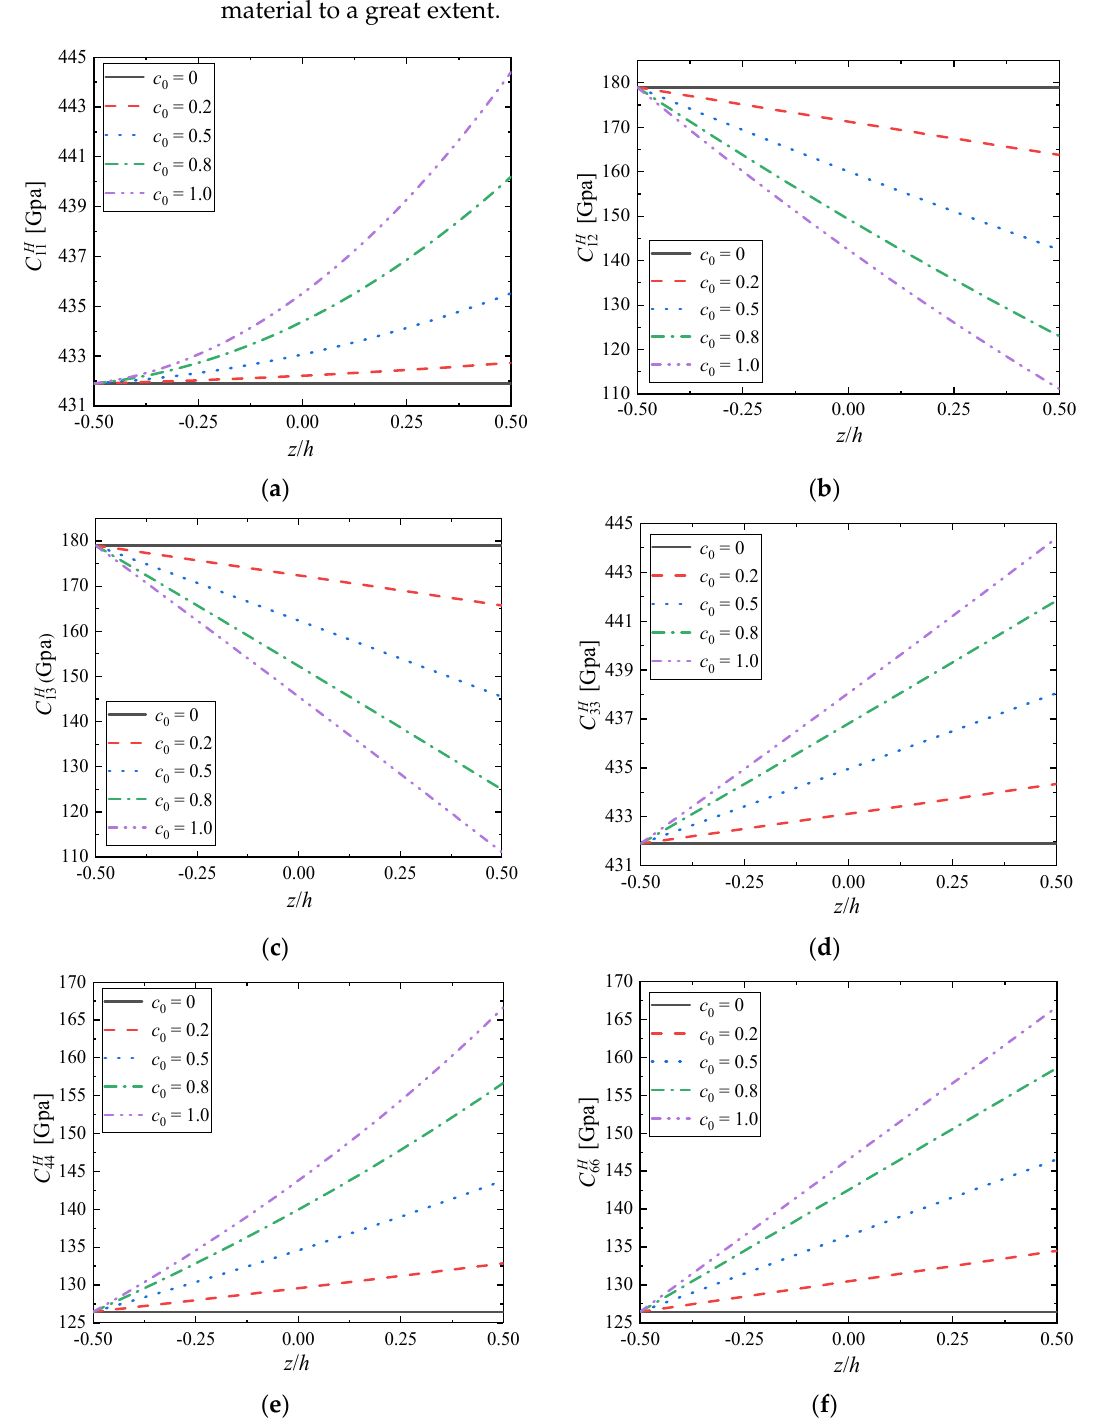
Figure 6. Distributions of ( a ) C 11 H ; ( b ) C 12 H ; ( c ) C 13 H ; ( d ) C 33 H ; ( e ) C 44 H ; ( f ) C 66 H along the gradient direction when m = 1.0. In Figure 7, when the component ratio coefficient c 0 = 1.0 [ V ZrC : V Mo = 0.5:0.5],